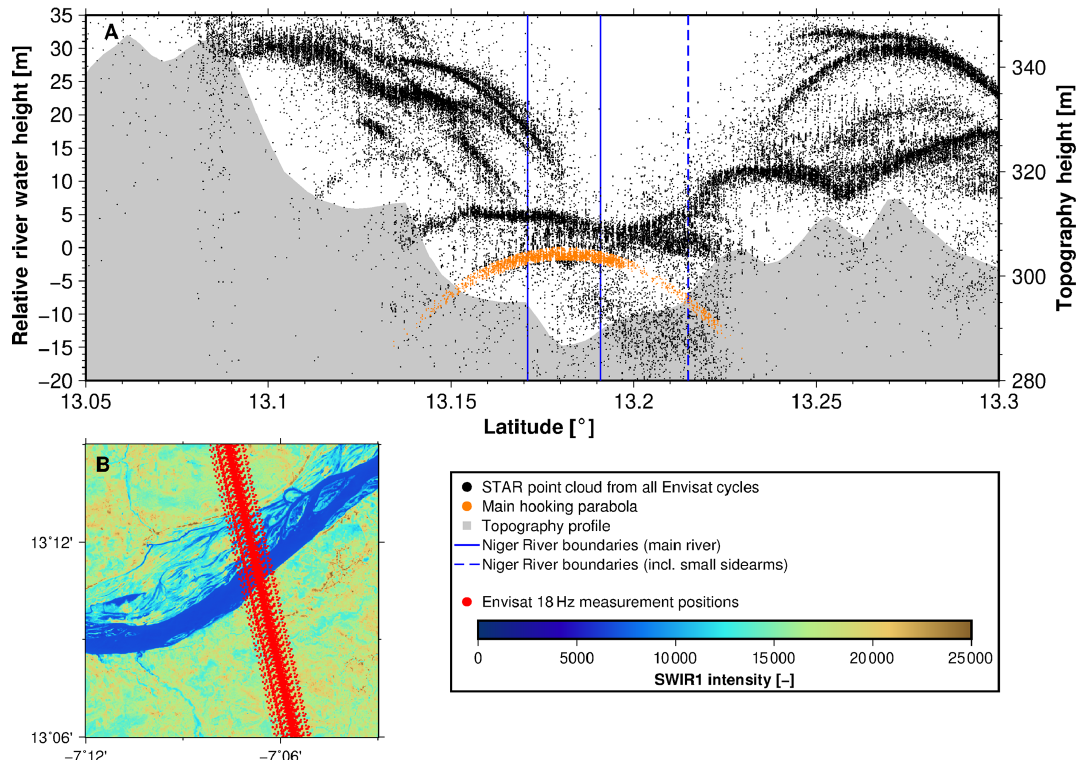
Figure 3. Hooking effect. (A) STAR point cloud from retracking all available Envisat cycles of P0259 crossing the Niger River. The main hooking parabola corresponding to the main river is marked in orange. (B) Virtual station of Envisat P0259 crossing the Niger River. The shortwave infrared (SWIR) information was extracted from Band 6 of a Landsat 8 image captured on 31 October